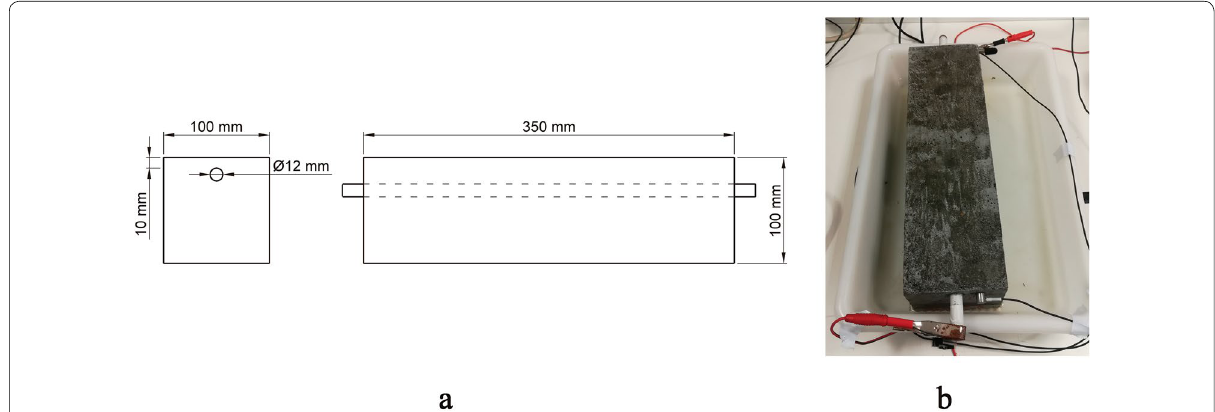
Fig. 2 a Dimensions of the reinforced cement mortar specimens. b Photo of one of the specimens before starting the corrosion test.